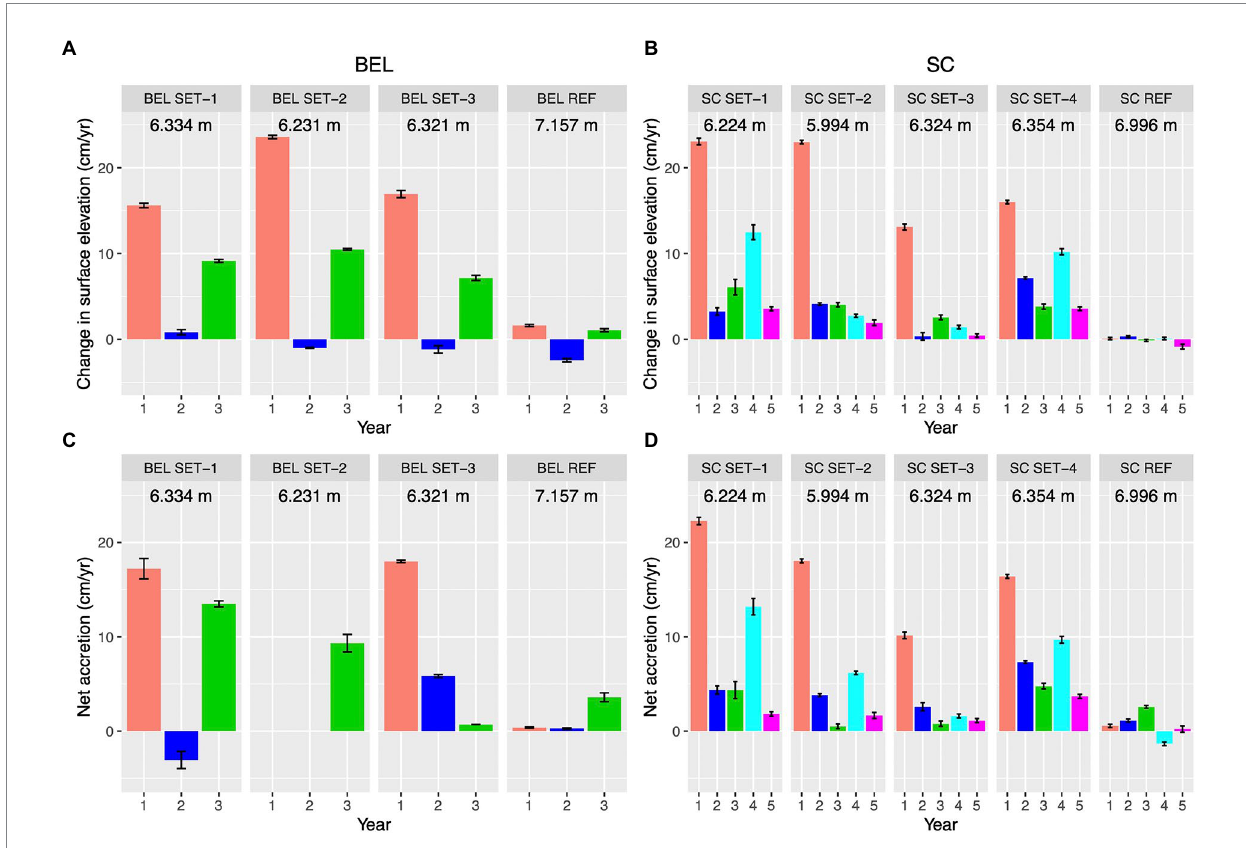
FIGURE 6 Surface elevation and sediment changes at BEL and SC restoration sites; error bars are standard errors; (A,B) Changes in surface elevation from RSET stations (Years post hydrological restoration); REF indicates reference site stations. Means are calculated across all pins on each station; (C,D) Accretion measured at RSET stations using marker horizons. Means calculated from three marker horizons per RSET location, REF indicates reference site